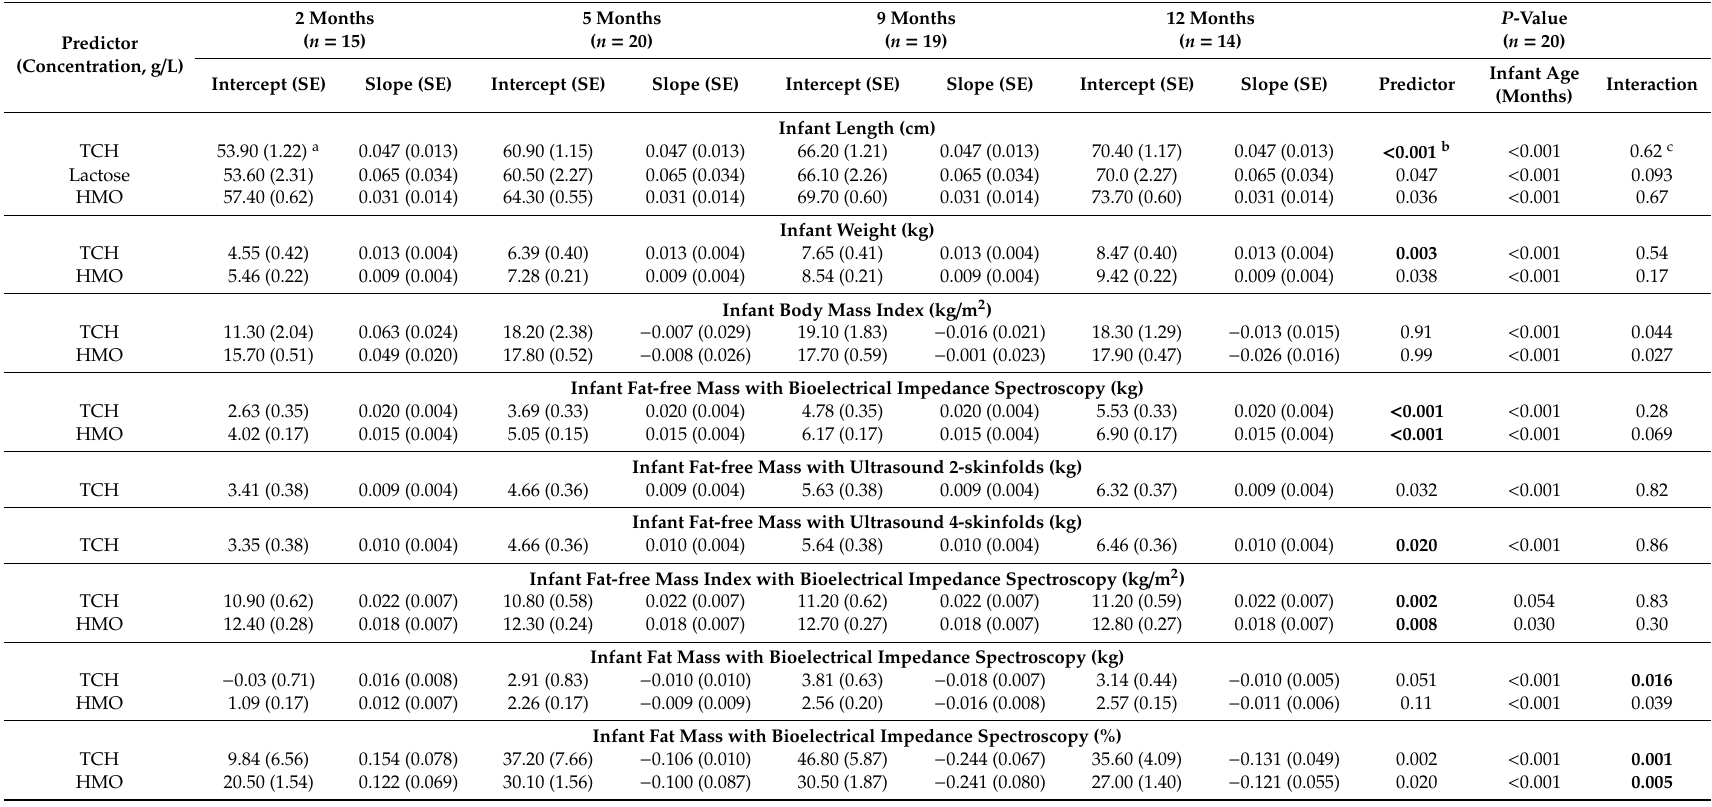
Table 3. Associations between concentrations of human milk carbohydrates and infant